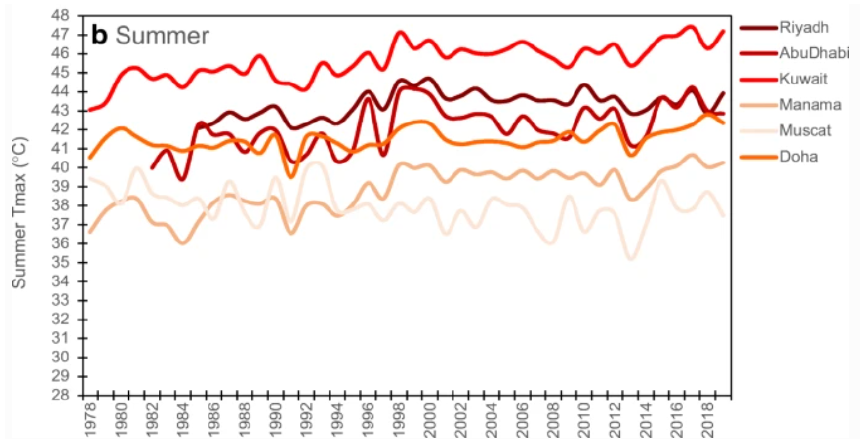
Figure 1. GCC: Average annual